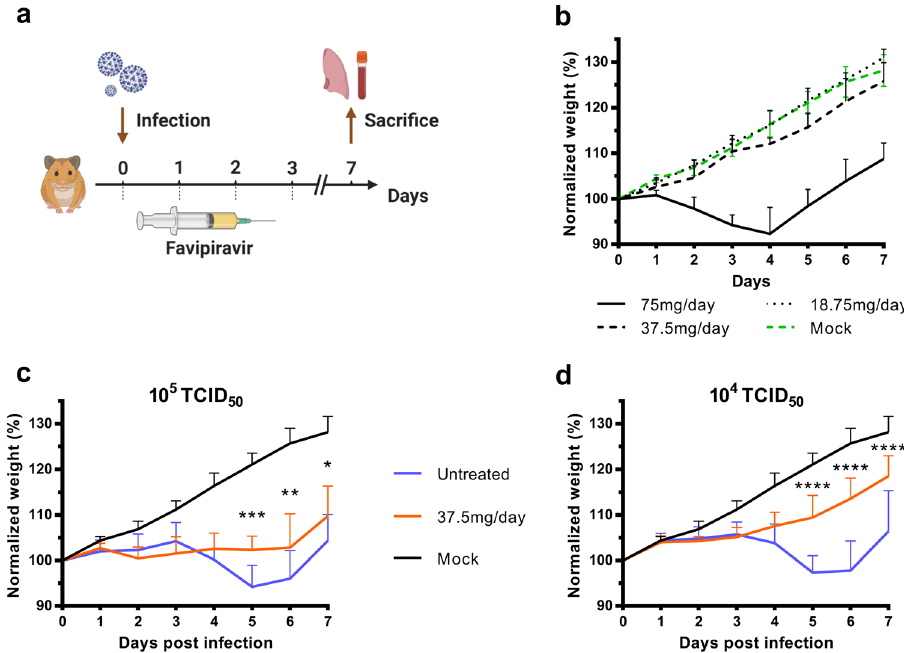
Fig. 2 Clinical follow-up of animals. a Experimental timeline. b Evaluation of the toxicity of the three doses of favipiravir (mg/day TID) with groups of four uninfected animals following the experimental timeline described in panel a but without infection. c , d Clinical follow-up with groups of 10 animals infected respectively with 10 5 and 10 4 TCID 50 of virus and treated with a dose of favipiravir of 37.5 mg/day TID. Normalized weight at day n was calculated as follows: % of initial weight of the animal at day n . Data represent mean ± SD (details in Supplementary Data 2). Two-sided statistical analysis were performed using two-way ANOVA with Post-hoc Dunnett ’ s multiple comparisons test or Post-hoc Sidak ’ s multiple comparisons test (details in Supplementary Data 5). ****, ***, ** and * symbols indicate that the average value for the group is signi fi cantly lower than that of the untreated group with a p -value < 0.0001, ranging between 0.0001 – 0.001, 0.001 – 0.01, and 0.01 – 0.05, respectively Source data are provided as a Source data fi le.